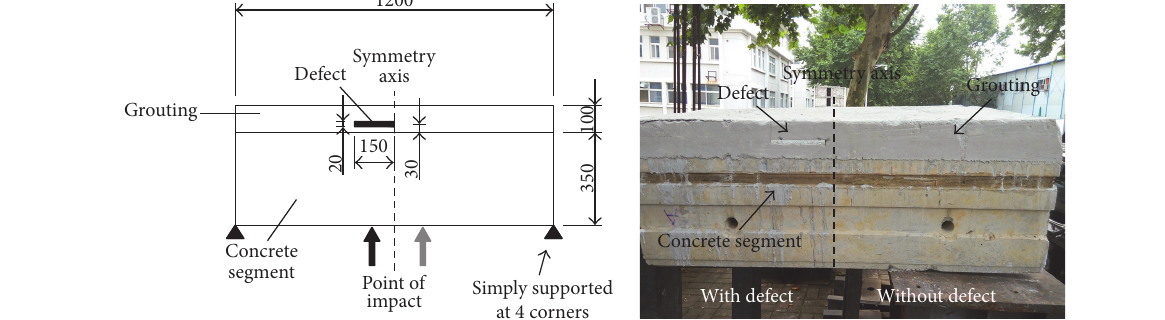
Figure 3: Structure of SG samples.